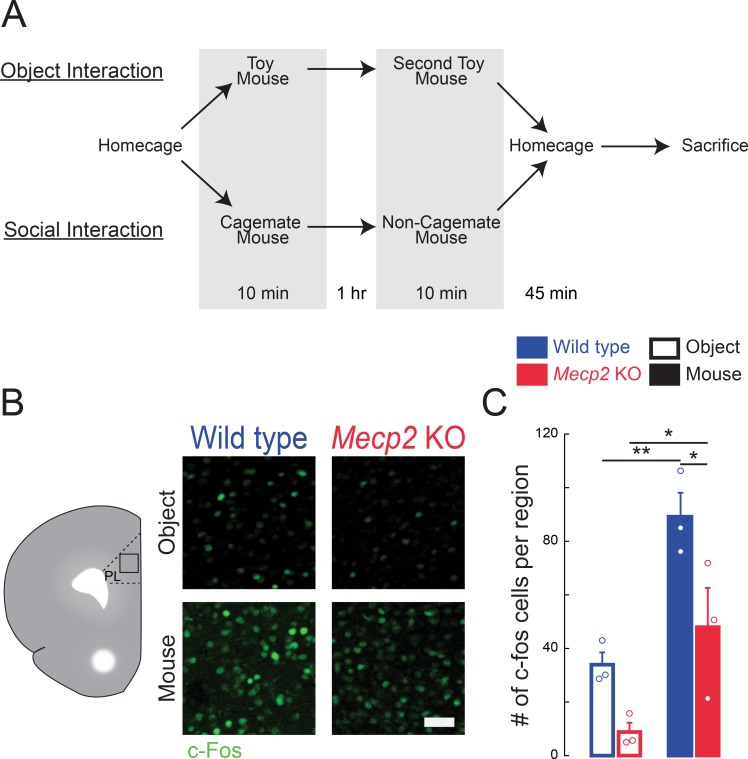
Higher number of c-Fos-positive neurons in the mPFC following social encounters.(A) Schematic of behavioral paradigm, also applicable for Figure 1. (B) Representative images of c-Fos immunostaining in the mPFC. (C) Number of c-Fos positive neurons in the PL region of the mPFC of mice who had interacted with either toy mice or live mice 45 min prior to sacrifice (WT toy mice vs. Mecp2 KO toy mice, p=0.1019; WT toy mice vs. WT live mice, p=0.0077; Mecp2 KO toy mice vs. Mecp2 KO live mice, p=0.0234; WT live mice vs. Mecp2 KO live mice, p=0.0234; Interaction p=0.4001; Experience p=0.0008; Genotype p=0.0063; Two-Way ANOVA with Benjamini and Hochberg Multiple Comparisons; n = 9 mPFC sections from three mice in each condition). Scale bar 50 μm. Mean ± SEM; *p<0.05, **p<0.01.10.7554/eLife.44182.004Figure 1—figure supplement 1—source data 1.Higher number of c-Fos-positive neurons in the mPFC following social encounters.